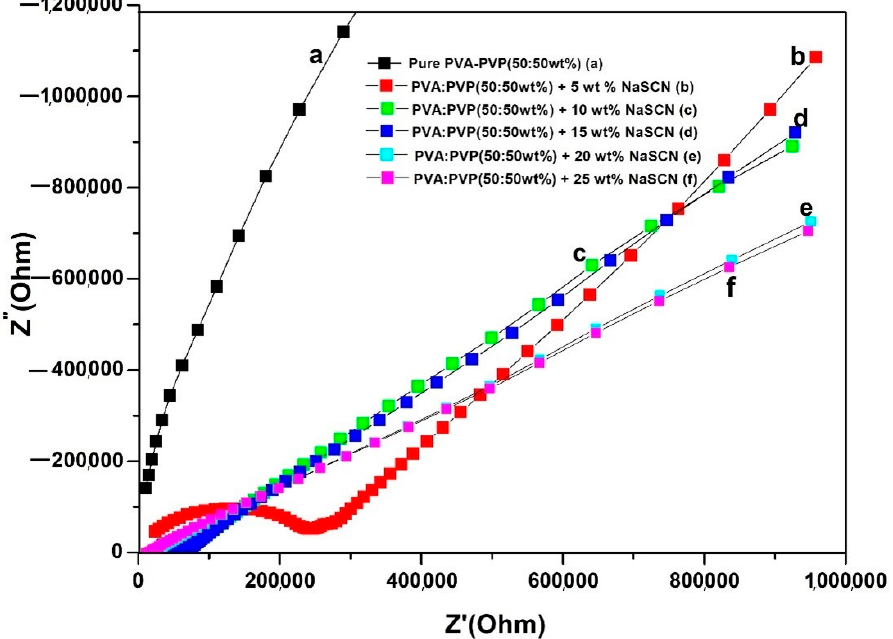
Figure 5. Nyquist plot for polymer blend electrolytes: (a) PVA: PVP (50:50 wt%), (b) PVA:PVP (50:50 wt%) +5 wt% NaSCN, (c) PVA:PVP (50:50 wt%) +10 wt% NaSCN, (d) PVA:PVP (50:50 wt%) + 15 wt% NaSCN, (e) PVA:PVP (50:50 wt%) +20 wt% NaSCN, and (f) PVA: PVP (50:50 wt%) +25 wt% NaSCN (f) at room temperature.